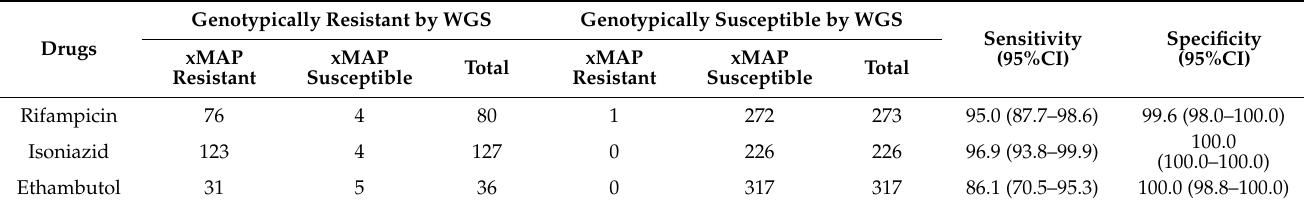
Table 3. Diagnostic performance of the xMAP TIER assay compared with WGS for detection of RIF, INH, and EMB